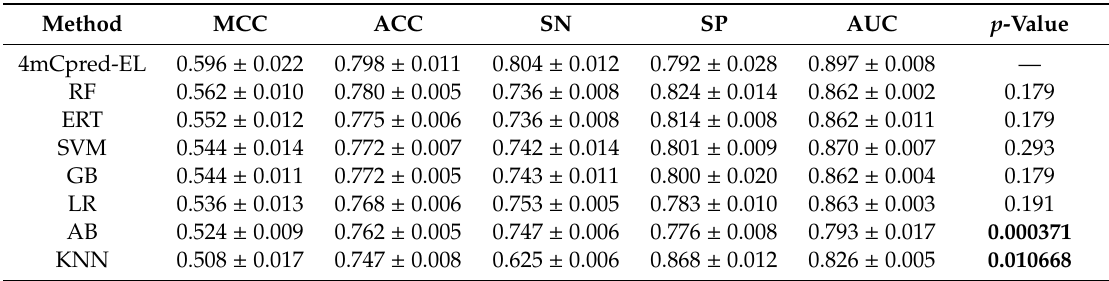
Table 2. Evaluation assessment between our proposed ensemble method and individual classifiers based on an independent test